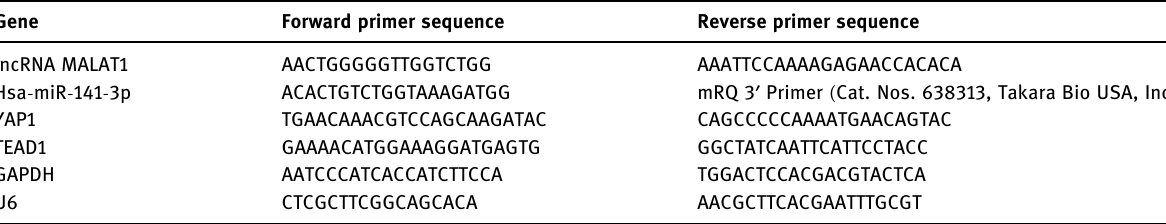
Table 1: Sequences of primers used for RT - qPCR